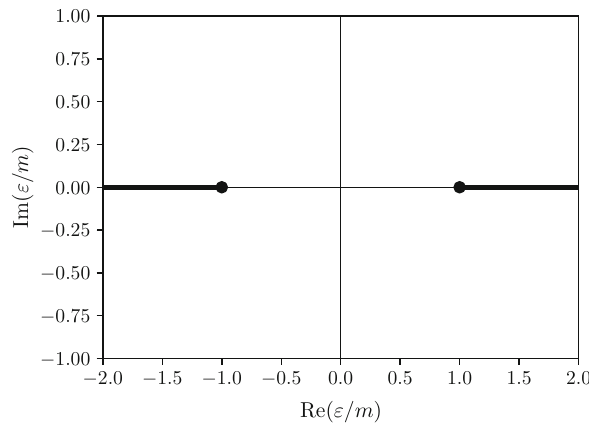
Fig. 1 The plane of complex energy